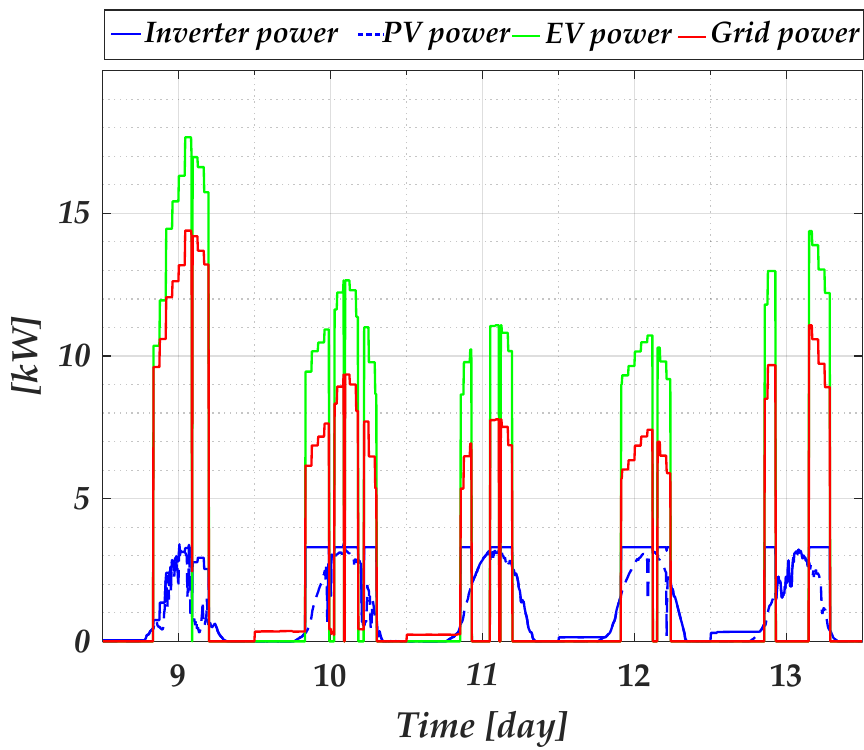
Figure 5. Day-ahead schedule power profile of the charging station (9th to 13th of May